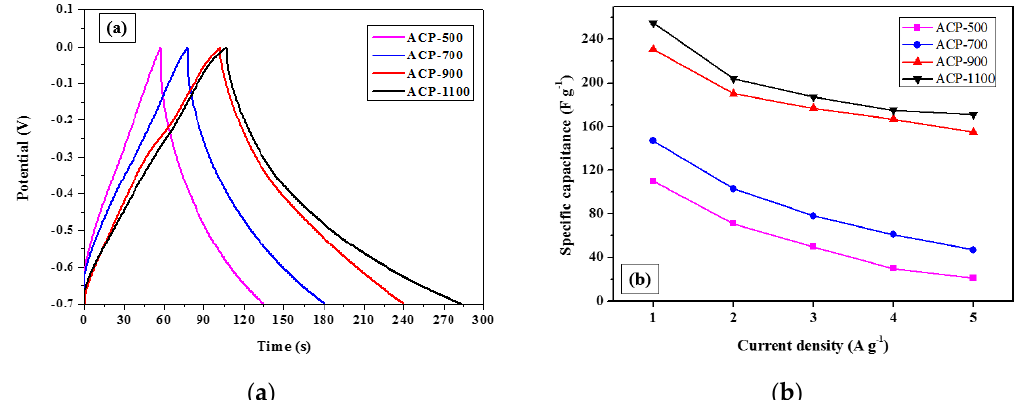
Figure 5. Galvanostatic charge-discharge (GCD) results: ( a ) GCD curves for ACP-500, ACP-700, ACP-900, and ACP-1100 electrodes with a current density of 1 A g − 1 and ( b ) specific capacitance for each ACP electrode vs. current density.